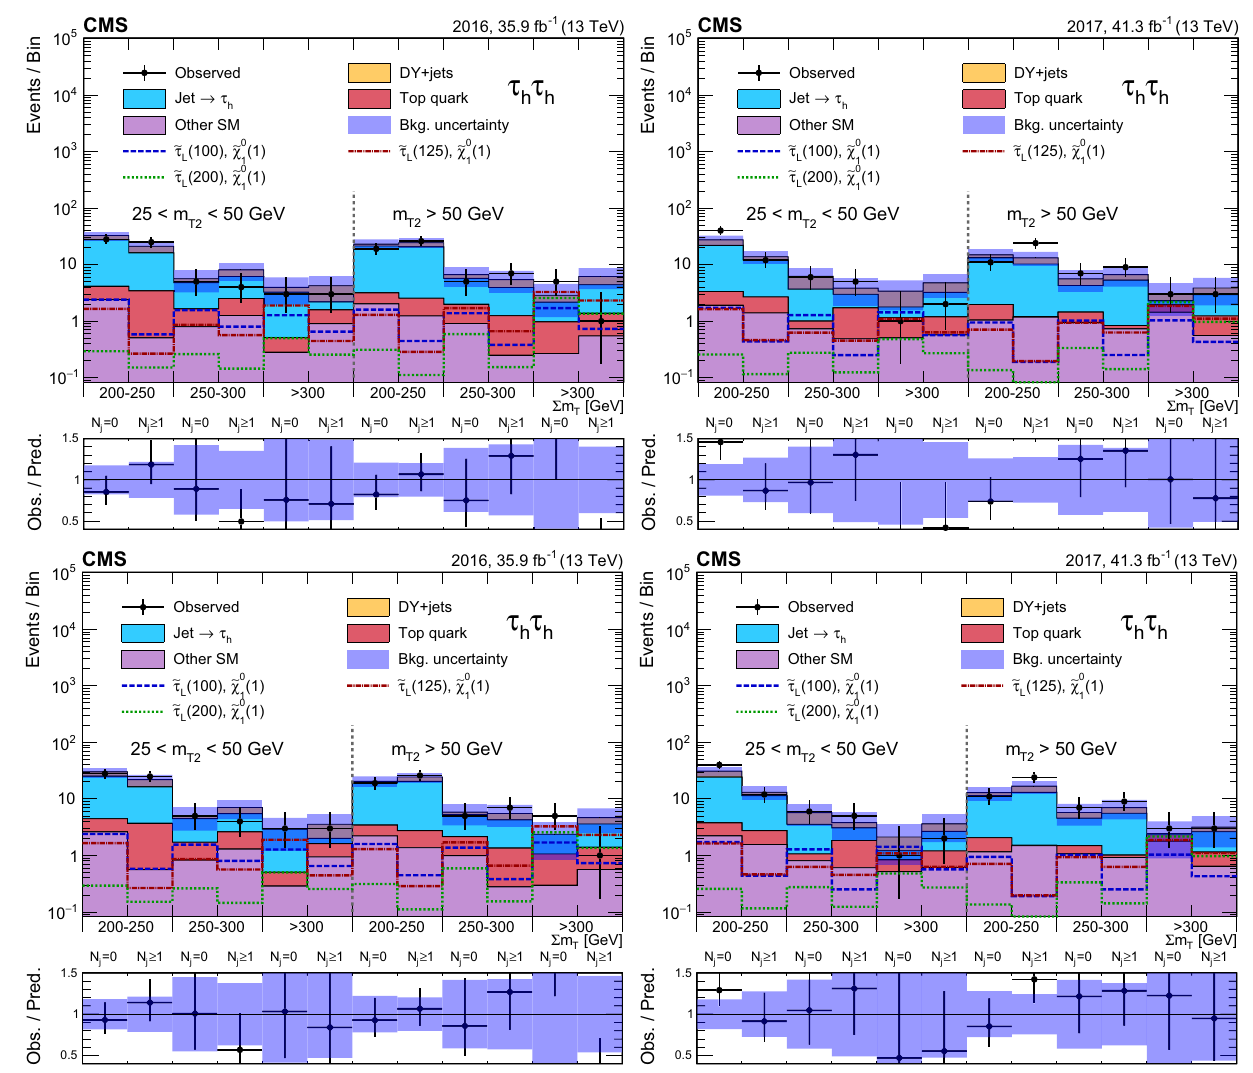
Fig. 5 Event counts and predicted yields for the SM background in the τ τ analysis for the 2016 (left) and 2017 (right) data, before (upper) h h and after (lower) a maximum-likelihood fit to the data. Predicted signal